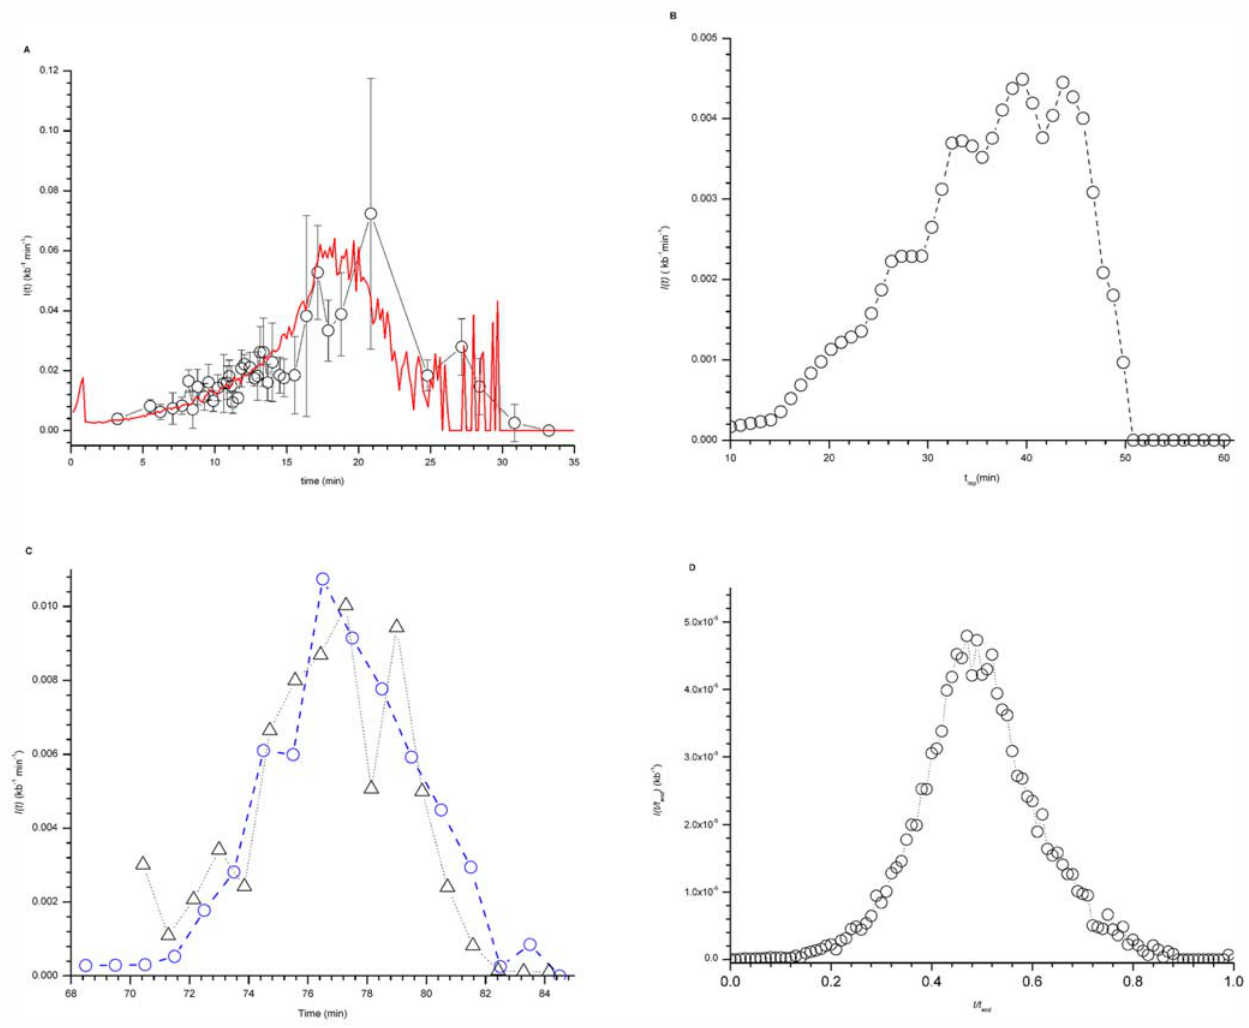
Figure 1. I(t) in X.laevis , S.cerevisiae , S.pombe and D.melanogaster . A. I(t) in X. laevis . I(t) was determined from DNA combing data (open circles) as described in Materials and Methods in [26]. The data points were binned into 40 points and the dispersion in data value of each bin was determined (gray standard deviation bars). The red line is the best fit of the numerical model [26] to the data ( x 2 =0.89). The values of free parameters as described in [26] are: P 0 =1.05 6 10 2 4 6 1.07 6 10 2 7 kb 2 1 s 2 1 , P 1 =2.1 6 10 2 3 6 2 6 10 2 5 kb 2 1 s 2 1 , J=5 6 0.5 s 2 1 and N 0 =1000 6 3. B. I(t) in S. cerevisiae was determined from the replication timing profiles of Raghuraman et al. [3] as described in the Materials and Methods. C. I(t) in S. pombe . Only the 401 strong origins defined by Heichinger et al. [4] (blue circles) and 516 potential origins defined by Eshaghi et al. [5] (black triangles) were considered. D. I(t/t end ) for D. melanogaster determined from replication timing profile of chromosome 2L [28].